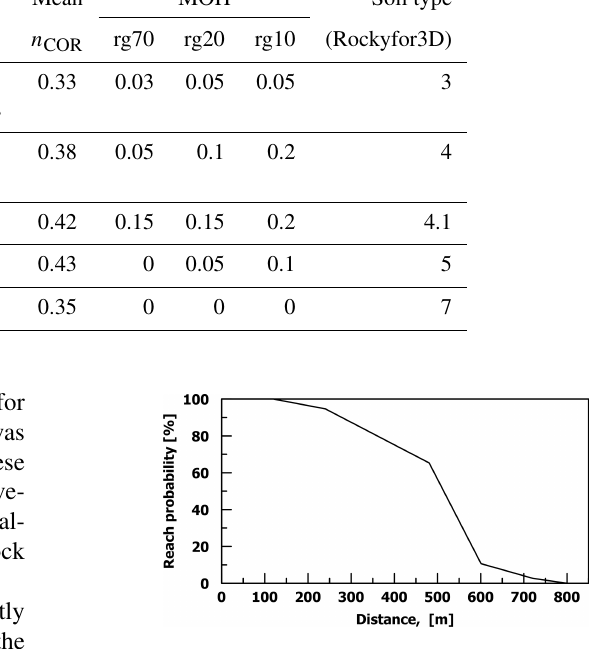
Figure 14. Reach probability graph calculated from 3-D rockfall